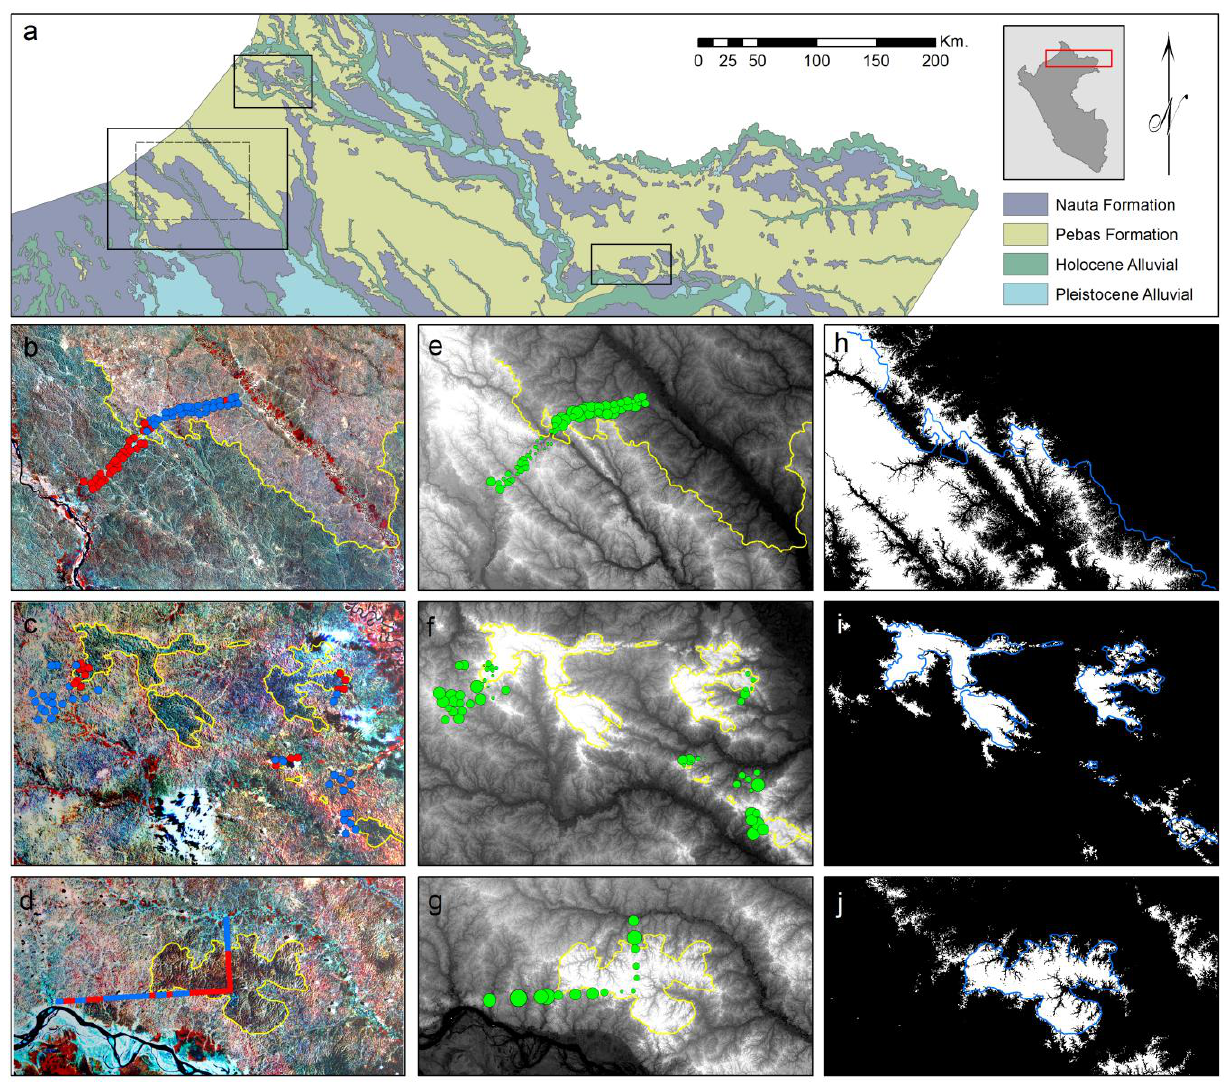
Figure 1. Geological, edaphic, and floristic patterns at three study areas in northern Peru. ( a ) Geological map for Peru [26], overlaid with the extents of the three study areas: from left to right, Pastaza-Tigre, Curaray, and Sucusari. Solid lines indicate extents of panels ( b – j ), with exception of panel (h), whose extent is indicated by broken lines. Inset shows location of (a) relative to map of Peru. (b–d) Plant inventories, divided into two groups by clustering analysis (red and blue points), and superimposed upon enhanced and detrended Landsat images for the Pastaza-Tigre, Curaray, and Sucusari study areas, respectively. (e–g) Soil cation concentrations superimposed upon Shuttle Radar Topography Mission (SRTM) digital elevation data, where the diameter of the circles is proportional to the sum of the concentrations of four cations (Ca, Mg, Na, and K). Lighter tones in the SRTM data indicate higher elevations; order of panels is as in (b–d). (h–j) Results of simple classification of SRTM data, where white pixels are above the elevation threshold and black pixels are below the elevation threshold; order as in (b–d). Yellow lines in (b–g) and blue lines in (h–j) indicate manual interpretations of Landsat